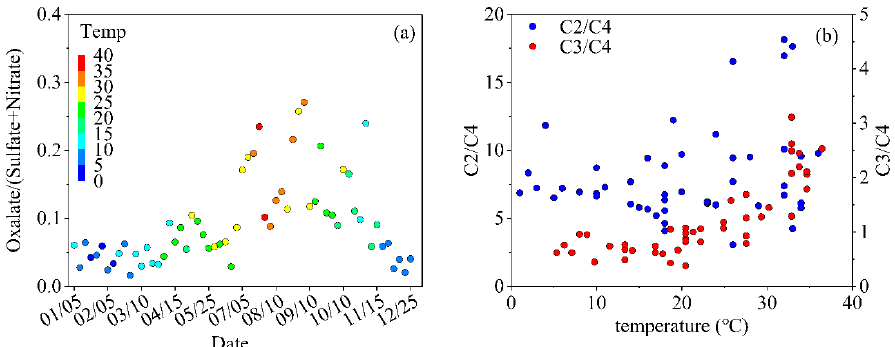
Figure 6. ( a ) Annual temperature distribution of oxalate/(sulfate + nitrate) for PD (2017); ( b ) Rela- tionship between C2/C4, C3/C4, and temperature, respectively.